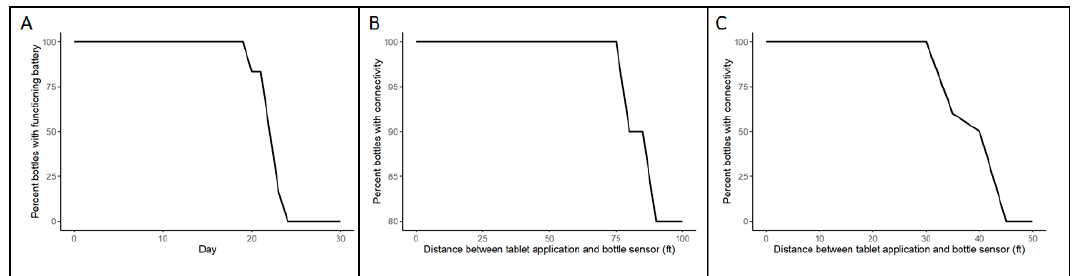
Figure 3. Each bottle squeeze consumes ~12 µ A for 3 ms. Intact bottles can achieve > 1000 pushes and BLE transmissions while battery voltage is over 1.8 V, the minimum input voltage for the Cypress programmable system on a chip (PSOC).